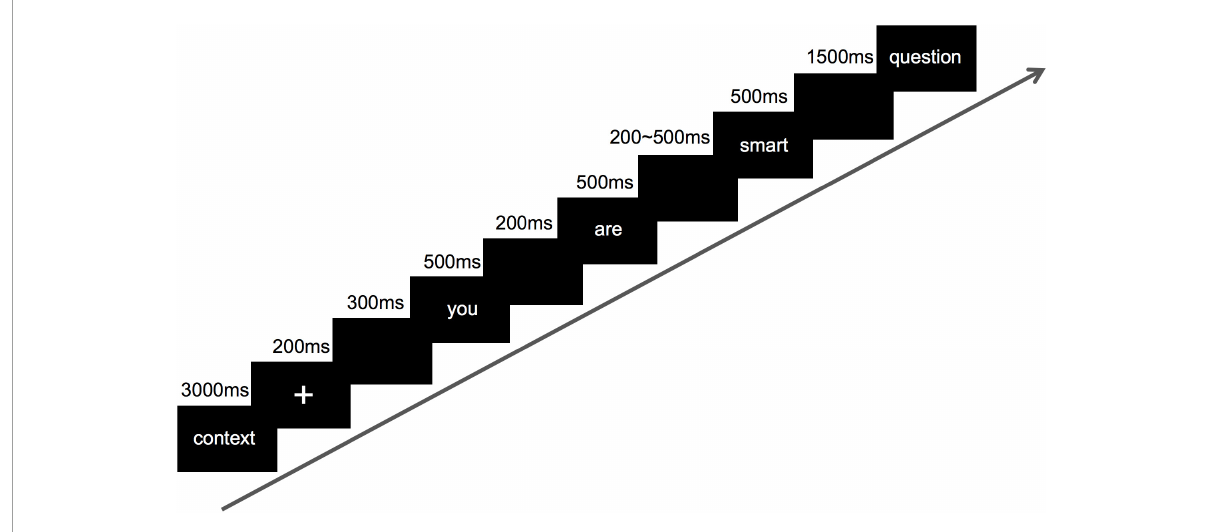
FIGURE1 Schematic representation of the experimental design.